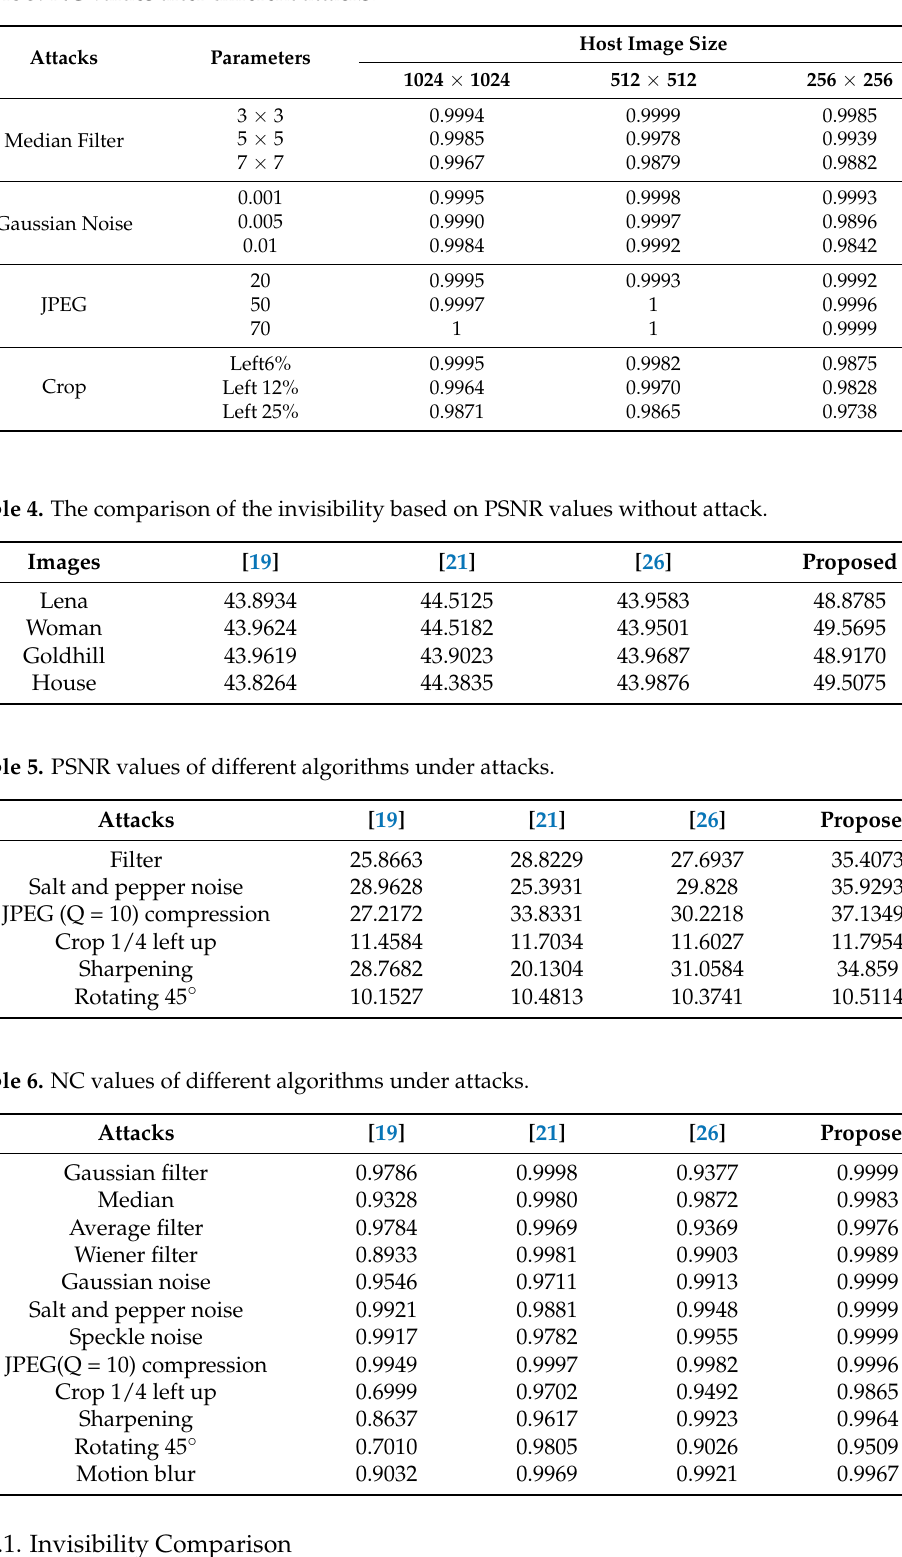
Table 3. NC values after different attacks.